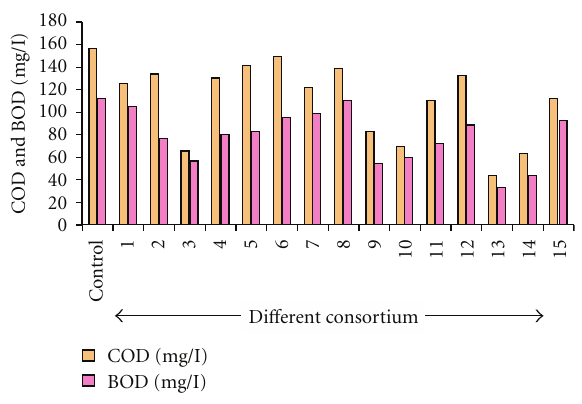
Figure 2: Comparison of BOD and COD for 15 consortia.